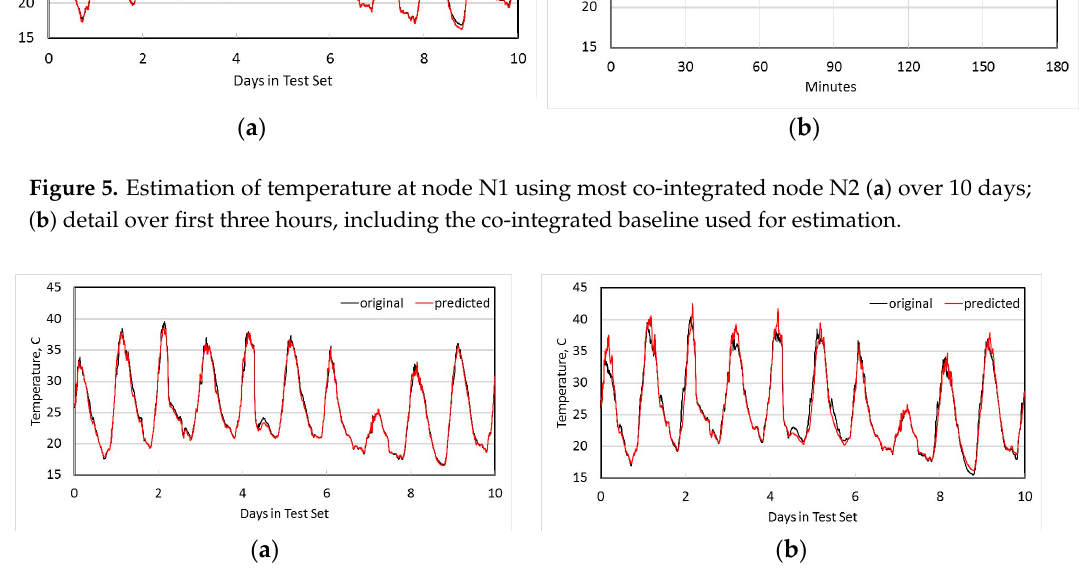
Figure 7. RMSE (moving average over 1 month) of prediction error using linear parameters from one week of training data in January. A second question is whether the co-integrated prediction is reliable into the future, given that the test data in Figures 5 and 6 is immediately after the training data. Figure 7 shows how the RMSE changes over the course of the next year, using estimation parameters from just one week of training